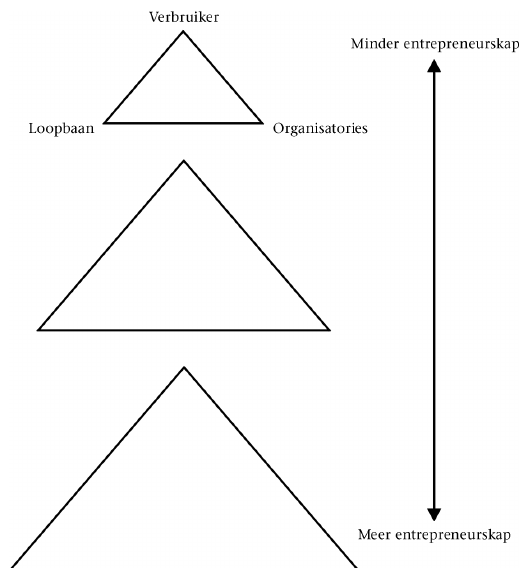
Figuur 8: Area van die driehoek as indeks van die intensiteit van entrepreneurskap (Na die idee van Sternberg, 1987)